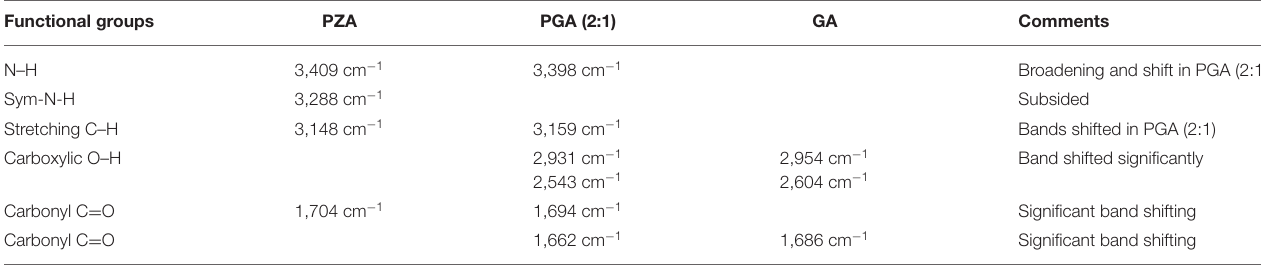
TABLE 3 | Summary of the different band shifting in the spectra of PGA (2:1) and their assignments. Functional